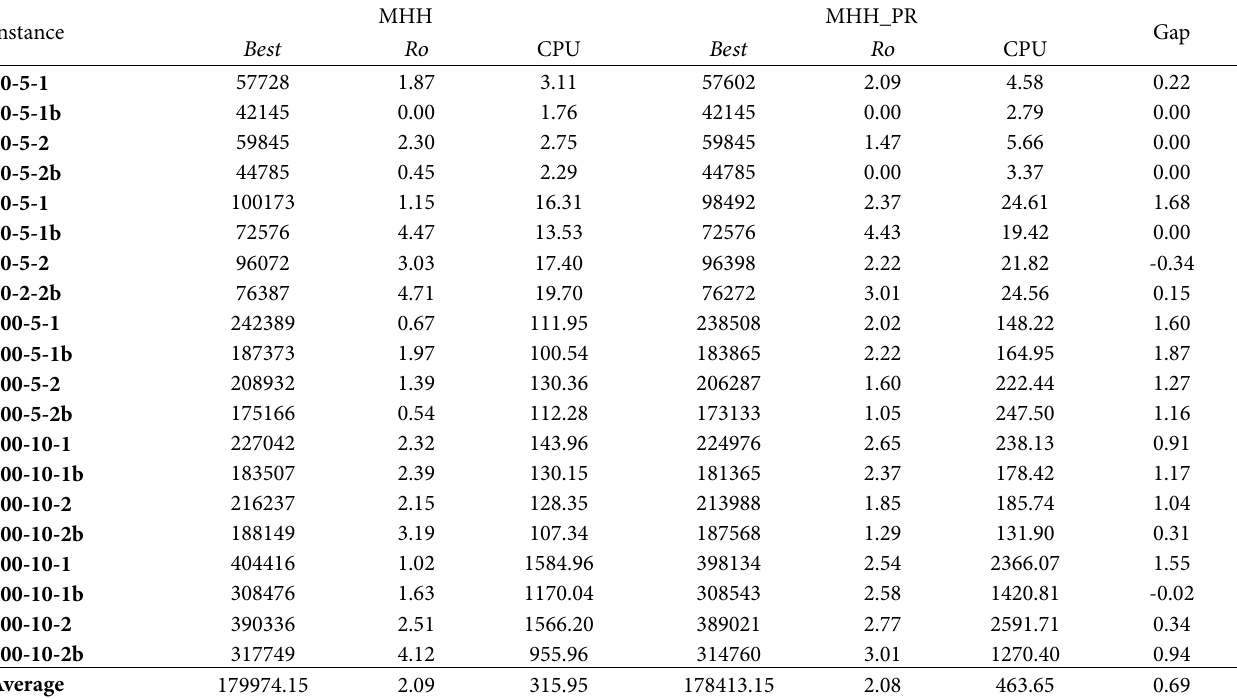
Table 5: Comparison of MHH and MHH-PR in 𝑋 -type 2E-LRPSPD instances.